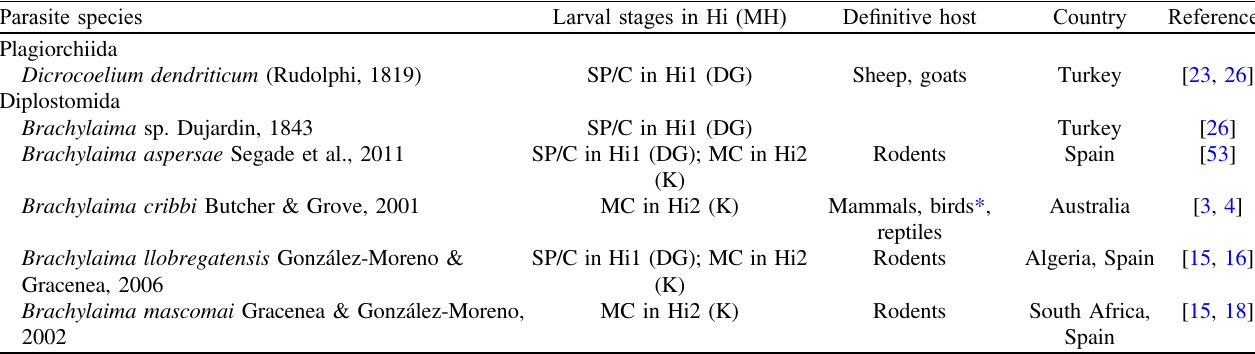
Table 2. Digenean trematode species parasitizing Cornu aspersum as fi rst (Hi1) and/or second (Hi2) intermediate host. Parasite